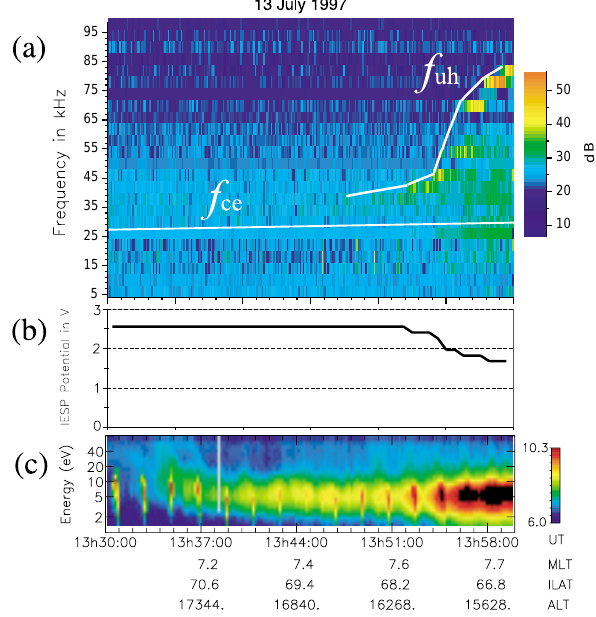
Fig. 9. Interball-2 data obtained on 13 July 1997 between 13:30 and 14:00 UT, around the plasmapause. From top to bottom: (a) wave spectrogram in dB from the POLRAD electric (Y) antenna, (b) spacecraft potential measurements in V with respect to the electric probes from the IESP experiment, (c) H + ion fluxes in (m 2 eVssr) − 1 versus time and energy from